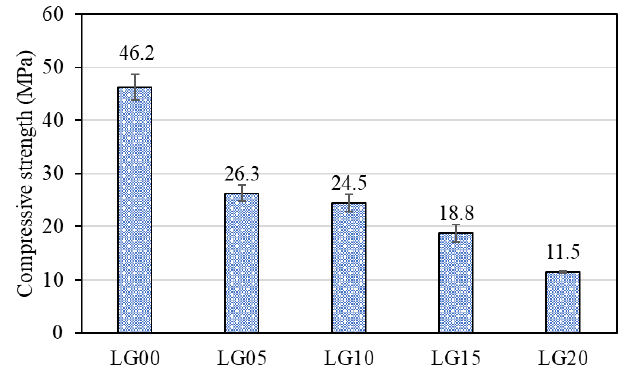
Figure 7. Compressive strength of geopolymer mortar containing BLWA.